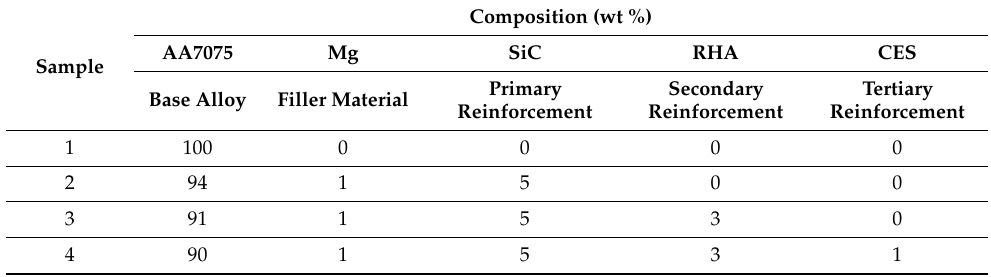
Table 1. The composition of casted